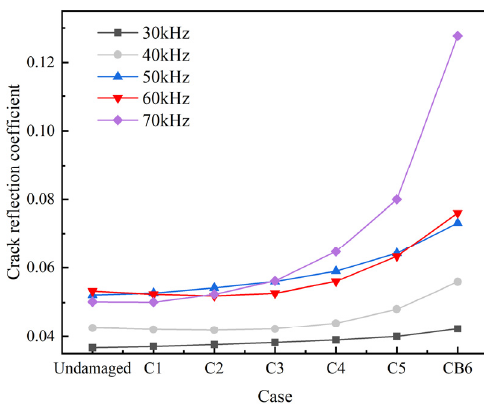
Figure 14. Crack reflection coefficient diagram.